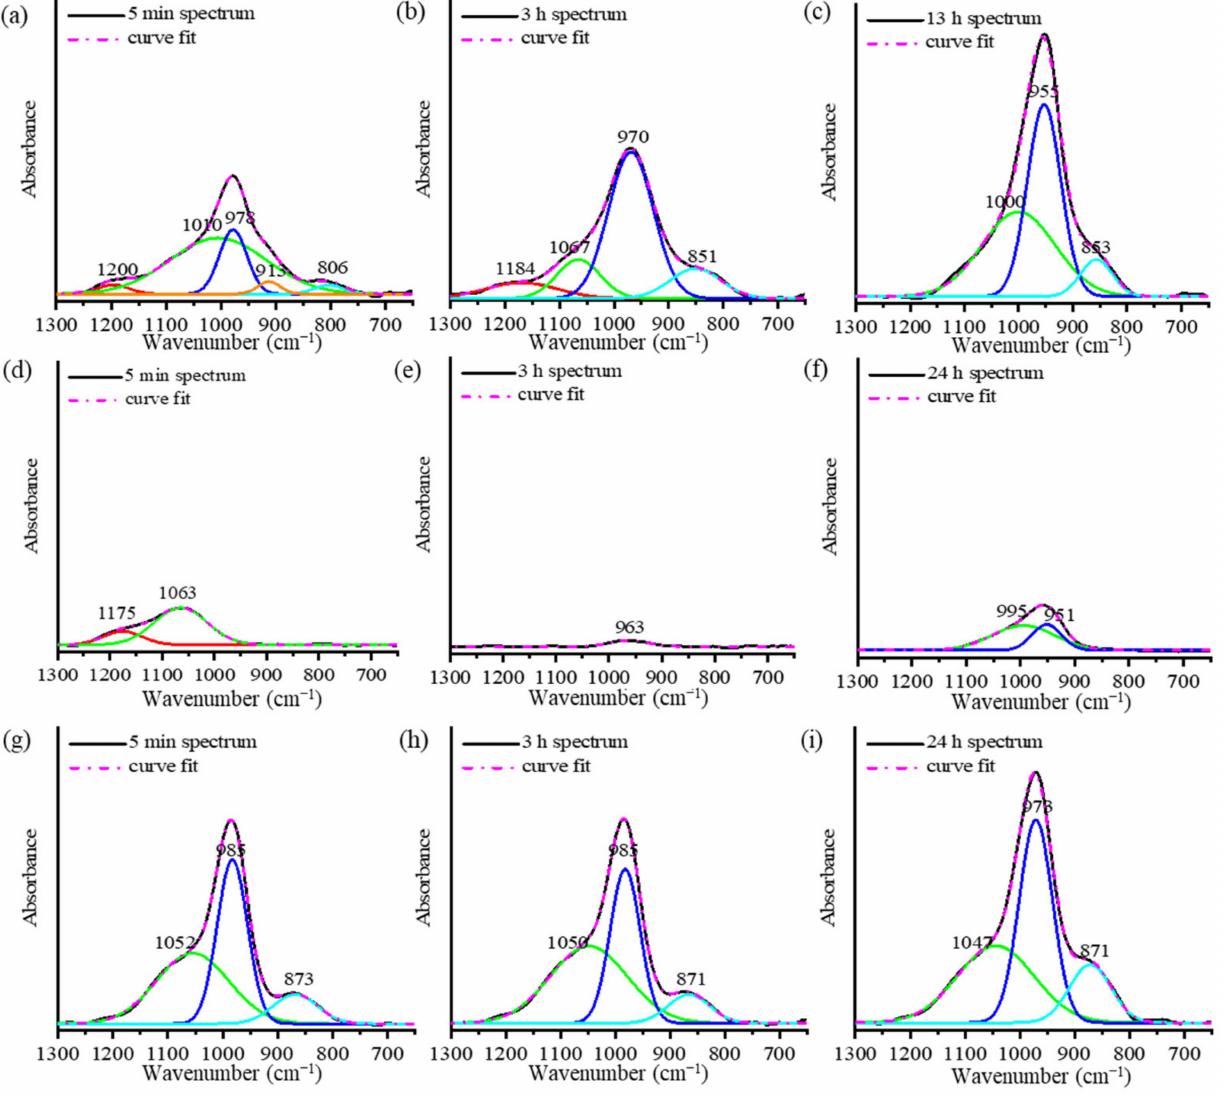
Figure 4. Deconvolution of the ATR-FTIR peaks of ( a – c ) the mixed solution-based AAM, ( d – f ) the NaOH solution-based AAM, and ( g – i ) the Na 2 SiO 3 solution-based AAM, at different time points. In Figure 2, the position of the main peak of the Si–O–M band is displayed as a function of time. The figure shows that the peaks of the Si–O–M bands in the AAM pastes have shifted to a lower wavenumber, which could be attributed to the replacement of Si–O–Si bonds by Si–O–Al and/or Si–O–Na bonds [21]. The kinetics of this reaction could be estimated using the slope of the curve; a low slope indicates slow kinetics [22]. The behaviors of the mixed solution-based AAM and the Na 2 SiO 3 solution-based AAM were similar; however, the mixed solution-based AAM reacted more quickly than the Na 2 SiO 3 solution-based AAM. The Si–O–M bond signals of the mixed solution-based AAM shifted to a lower wavenumber (from approximately 980 to 950 cm − 1 ) after 780 min (13 h). The peak of the Na 2 SiO 3 solution-based AAM also shifted to a lower position (from 985 to 970 cm − 1 ) after 1140 min (24 h). In the spectra of the NaOH solution-based AAM, the peak in the Si–O–M band has shifted two times. First, the peak shifted from 1060 to 1050 cm − 1 115 min after the reaction. Thereafter, it suddenly shifted to 980 cm − 1 and continued to move toward lower wavenumbers. This result indicates that the NaOH solution has had a strong reaction with metakaolin at approximately 2 h after the